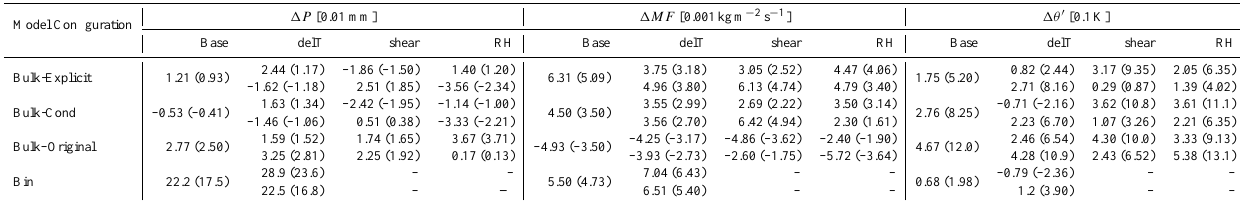
Table 2. Summary of results for the suite of model configurations described in Table 1. The change in precipitation ( 1P ), convective mass flux ( 1MF ), and average potential temperature within the cold pool ( 1θ 0 ) are shown for “Polluted” minus “Clean” conditions. Statistics for 1MF are computed by averaging between t =30 and 120min and between z =2.1 and 9.1km. For 1θ 0 and 1P the results are shown only for t =120min. The percent change relative to the “Clean” case is shown in parentheses. Within each column, the top values correspond to the low perturbation sensitivity simulations while the bottom values correspond to the high perturbation simulations (i.e., the delT25 run is above the delT35 run,